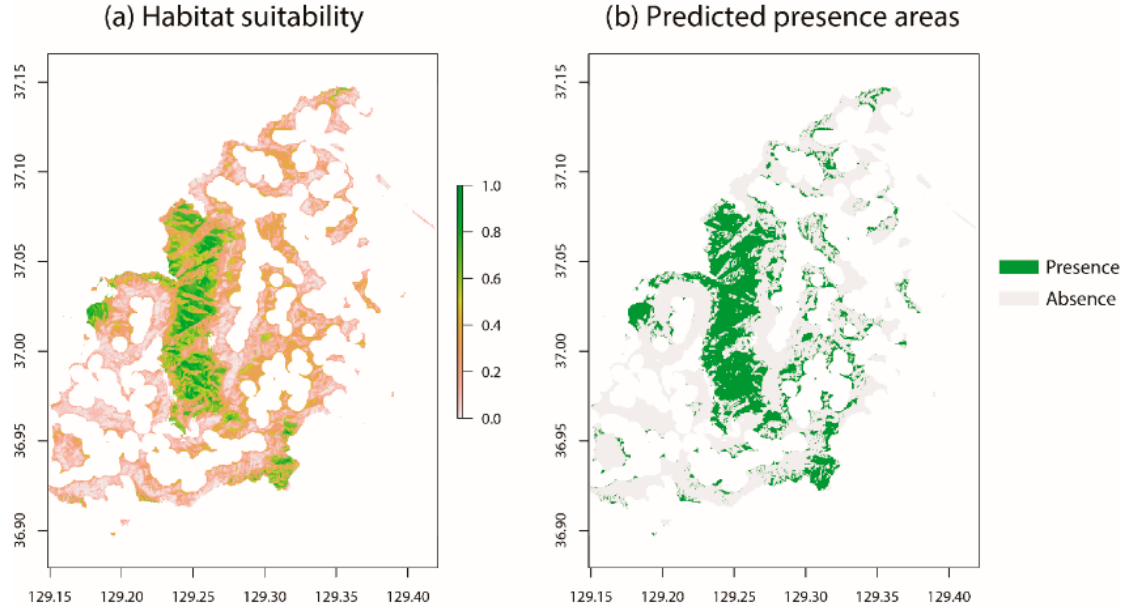
Figure 7. Mortality probability due to heavy snowfall ( a ) and predicted mortality areas ( b ) within the study sites. ( a ) Areas with high mortality are represented in green, whereas low mortality areas are represented in pink; ( b ) areas of predicted death are represented in green.